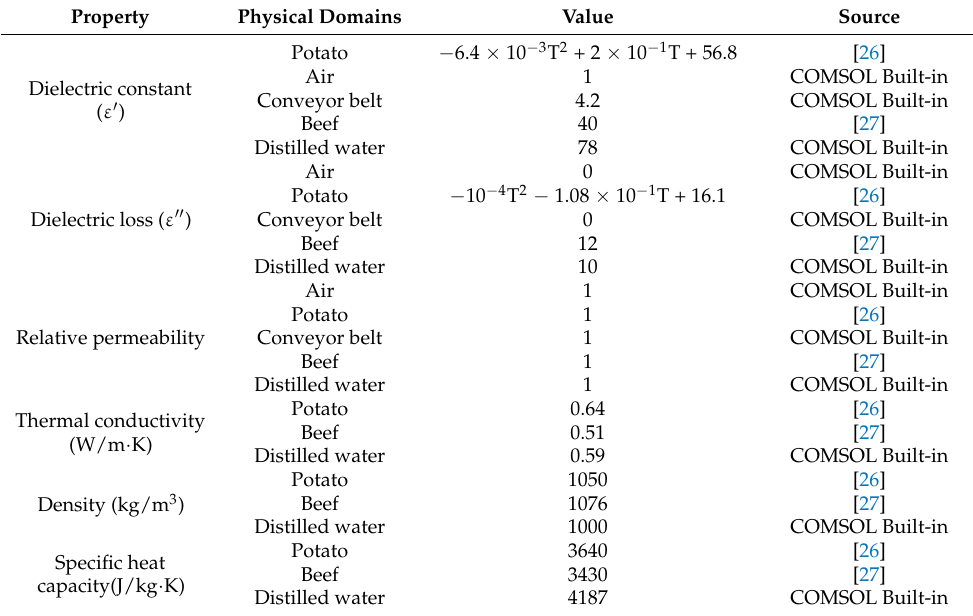
Table 1. Material properties in physical domains of the proposed model.